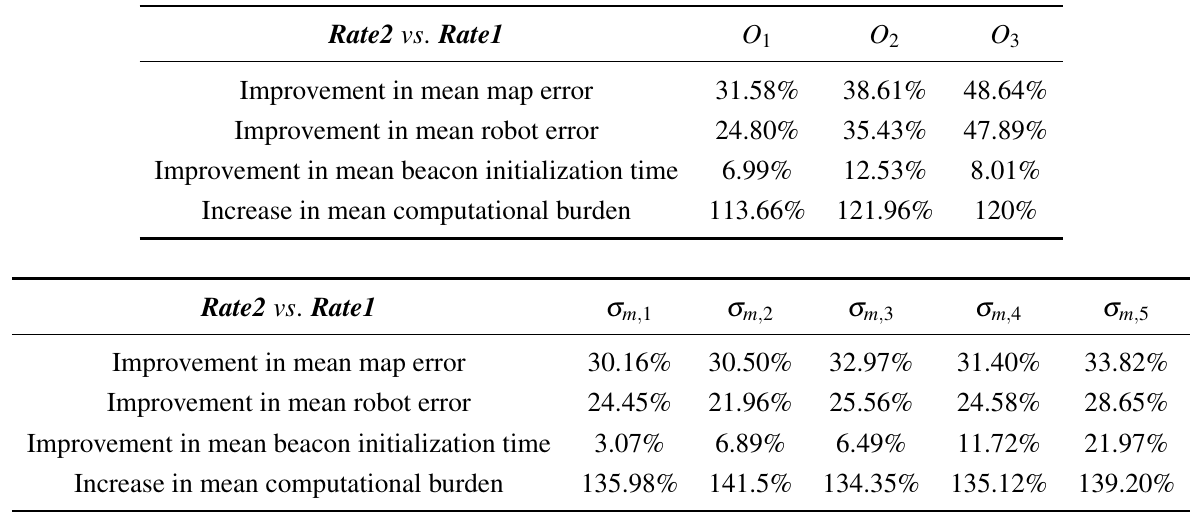
Table 2. SLAM performance evaluation between Rate2 and Rate1 with different odometry levels ( top ) and with different measurement noise levels ( bottom